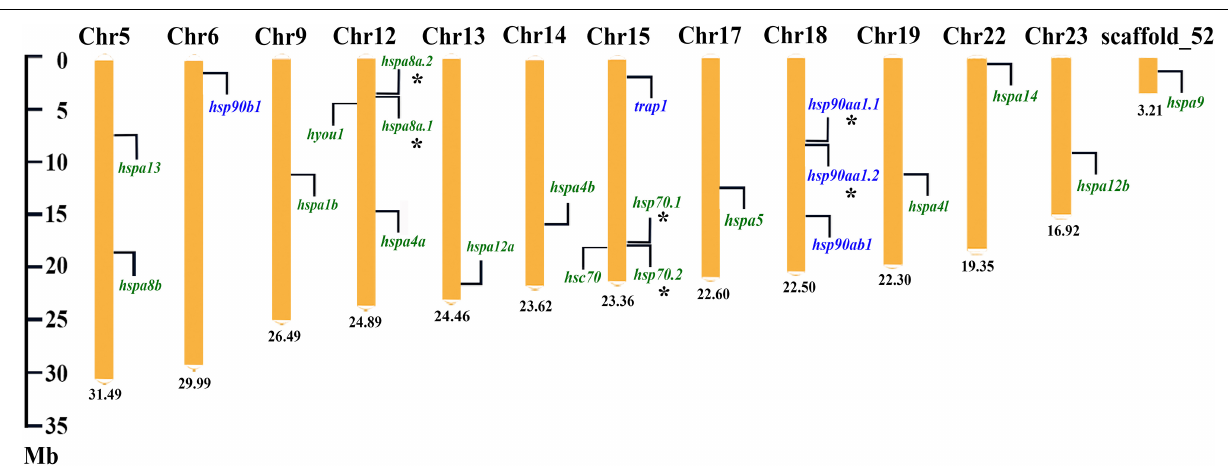
and hsp90aa1.2 harbored highly similar exon-intron structures ( Figure 4A ). Contrastingly, the intron numbers of the HSP70 genes were remarkably varied from 0 to 22 ( Figure 4B